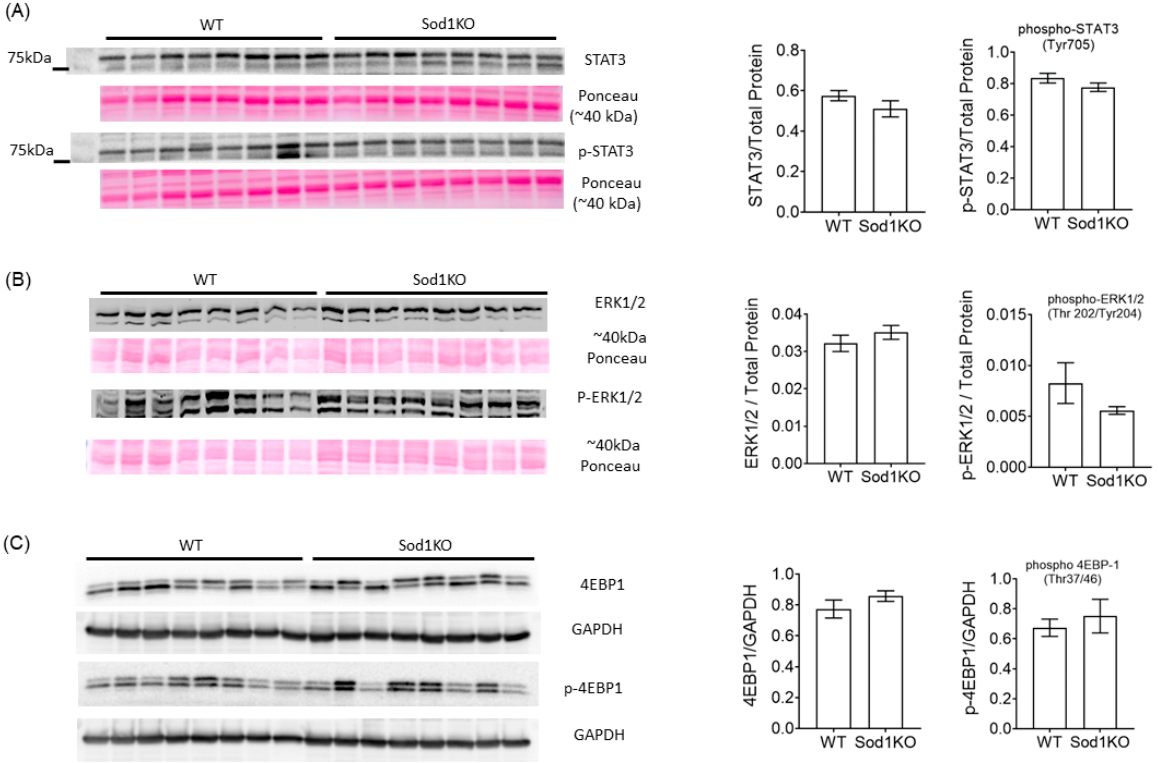
Figure 5. Downstream targets of oxidative modifications remained unchanged in Sod1KO. ( A ) Left: Immunoblot images showing total STAT3 and phosphorylated STAT3 in heart lysates. Right: Quantified total STAT3 and phosphorylated STAT3 at Tyr705, normalized to total proteins ( n = 8). ( B ) Left: Immunoblot images showing total ERK1/2 and phosphorylated ERK1/2. Right: Quantified total ERK1/2 and phosphorylated ERK1/2 at Thr202 and Tyr204, normalized to total proteins ( n = 8). ( C ) Top: Immunoblot images showing total 4EBP1 and phosphorylated 4EBP1 in heart lysates. Bottom: Quantified total 4EBP1 and phosphorylated 4EBP1 at Thr37 and 46 sites, normalized to GAPDH ( n = 8). Data are mean ± SEM. Abbreviations: 4EBP1 = eukaryotic translation initiation factor 4E-binding protein 1; ERK = extracellular signal-regulated kinases.